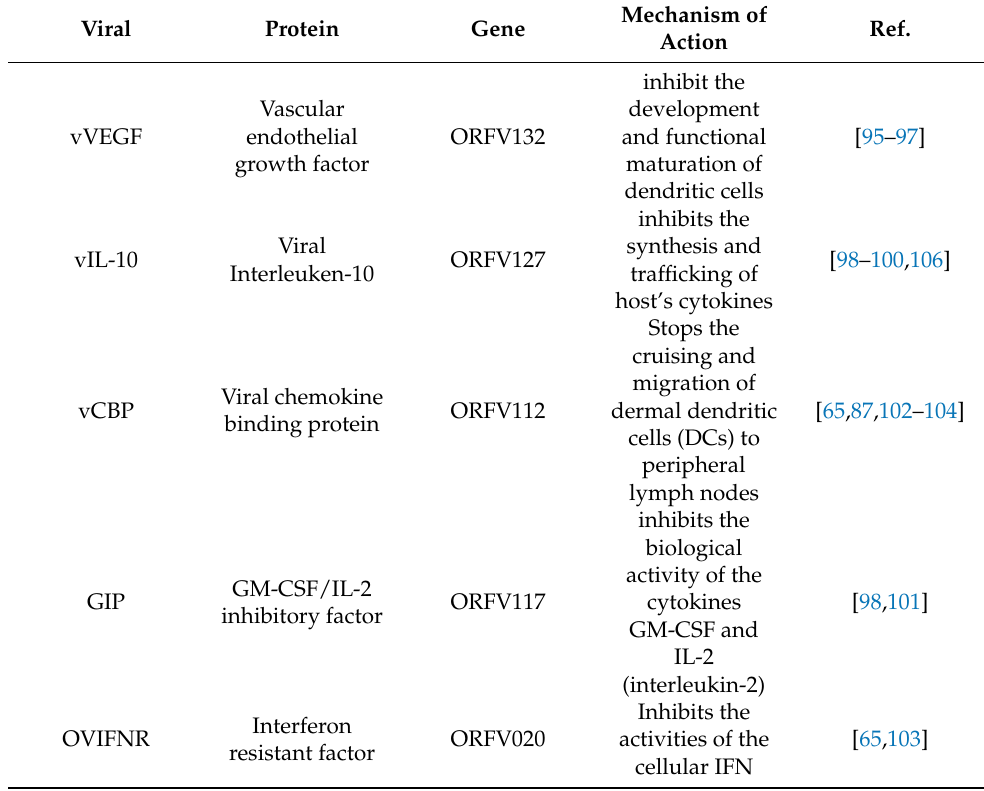
Table 1. Major immuno-modulator and virulent genes and proteins encoded by ORFV. Viral Protein Gene